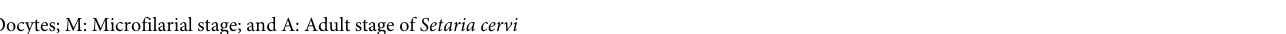
O: Oocytes; M: Microfilarial stage; and A: Adult stage of Setaria